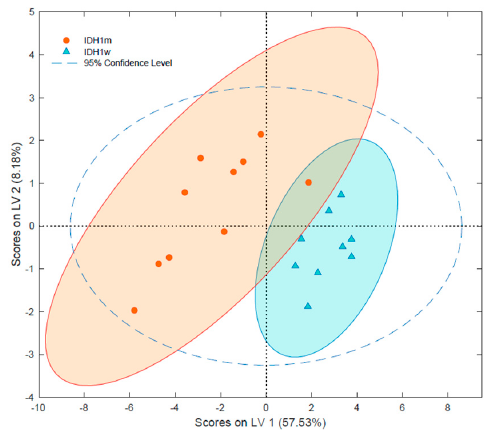
Figure 5. Partial least square data analysis (PLS-DA) of gliomas with different IDH mutation statuses. IDHm—isocitrate dehydrogenase gene mutant; IDHw—isocitrate dehydrogenase gene wiltype.